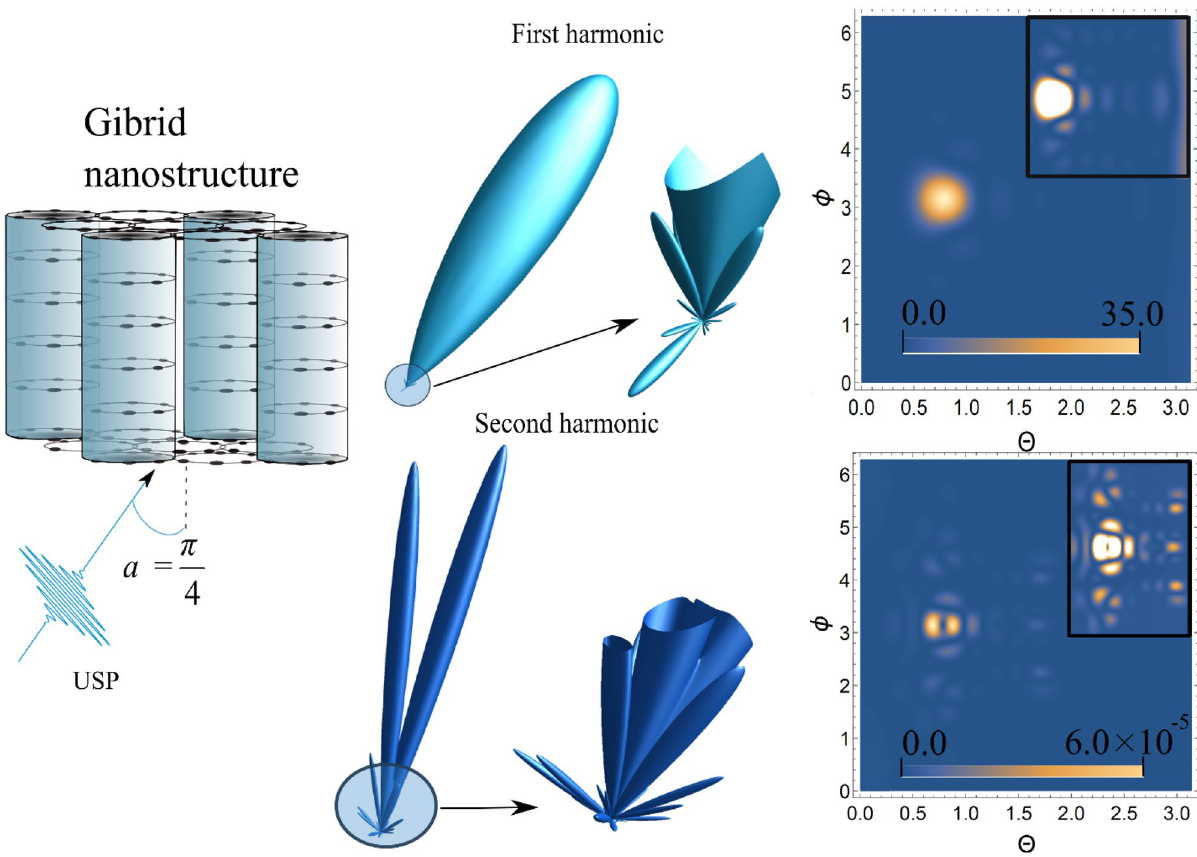
Figure 4. 3D radiation pattern of the scattering spectra USP [see Eq. (1)] and the contour plot for the spectra, where θ and φ are angles (in radians) with a spherical coordinate system, i.e. polar and azimuth angles, respectively. Inserts in contour plots show an enlarged (more contrasting) scatter spectrum. The first harmonic is in the figures above, and the second harmonic is below. A USP was selected with a frequency ω 0 =100 au, a pulse duration γ corresponding to 43 as and amplitude E 0 = 1000 au. The numbers of nodes n 3 = 5 , = d = d = 5 au, number of atoms in a ring N = 6 , and ring radius R = 3 au. The = n = 3 , distance d n 1 3 3 1 2 angle of incidence α between n 0 and z axis was selected as α = π/ 4